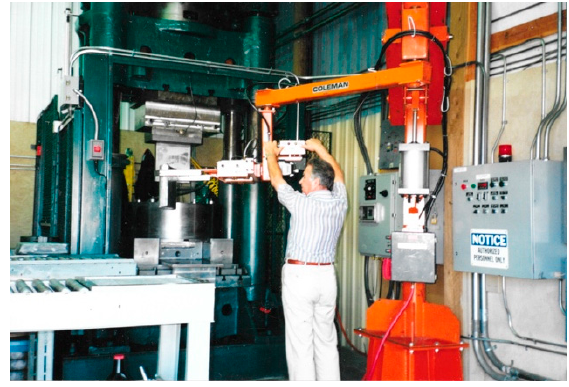
Figure 10. Billet loading in the die.